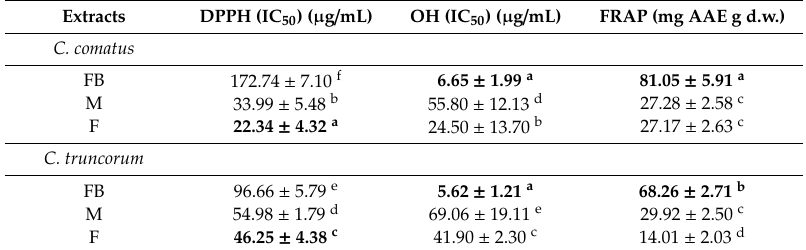
Table 1. Antioxidant activity of the methanolic extracts of the mushrooms Coprinus comatus and Coprinellus truncorum . FB—Fruiting Body; M—Mycelium; F—Filtrate; DPPH—DPPH assay; OH—OH assay; FRAP—FRAP assay; AAE—ascorbic acid